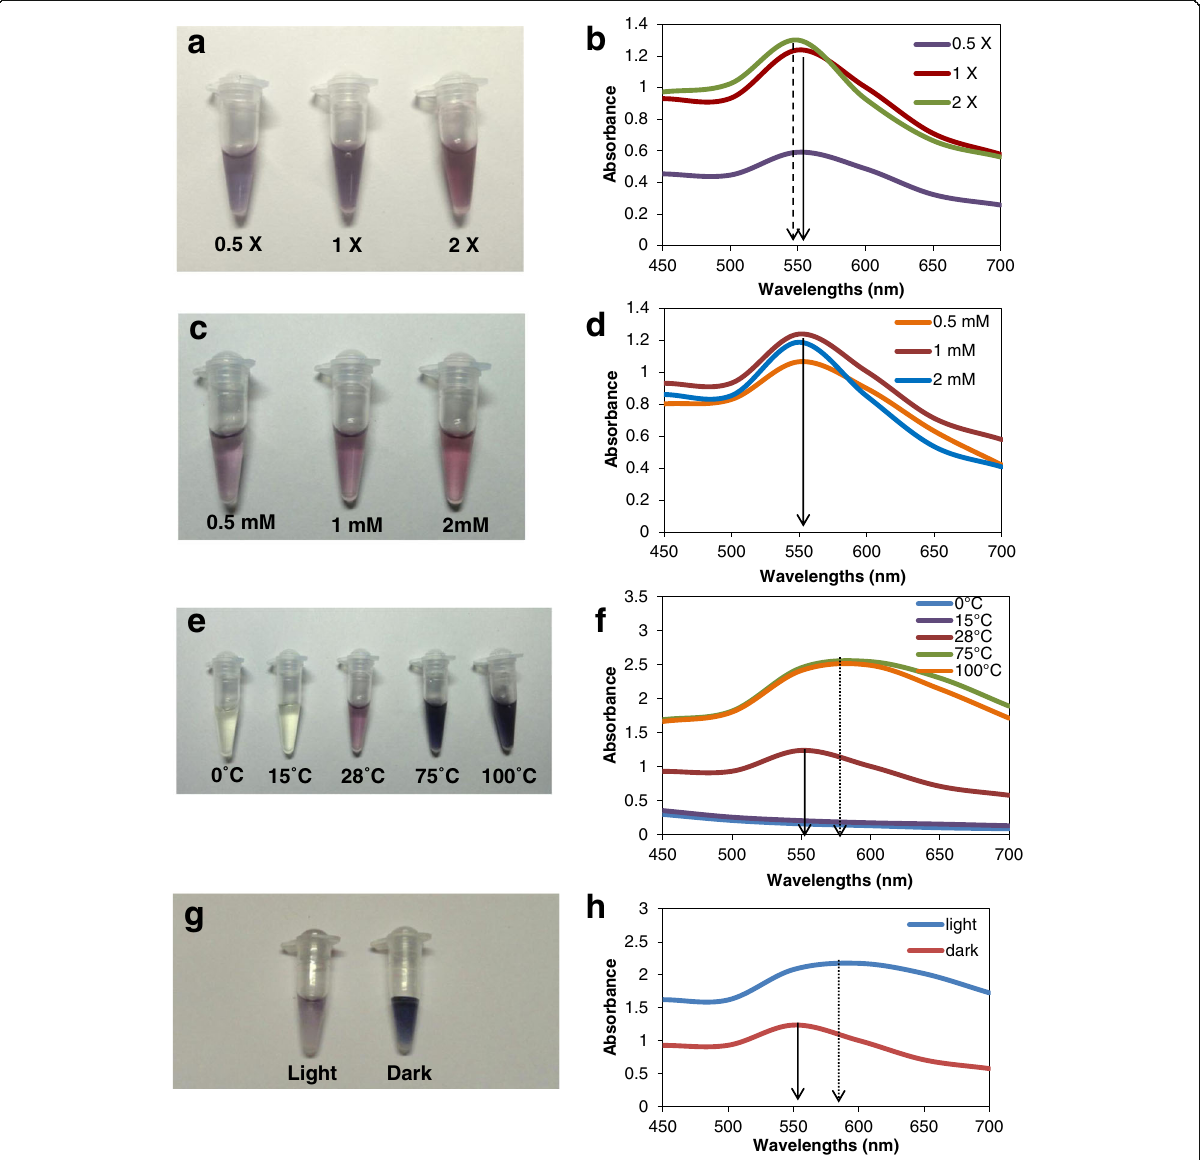
Fig. 2 Biosynthesis and UV-vis spectroscopy of AuNPs from Tricholoma crassum using different synthesis parameters. a , b Different concentrations of cell-filtrate. c , d Different concentrations of HAuCl 4 . e , f Different reaction temperatures. g , h In dark and under light. Solid arrow shows the typical absorption peak at 552 nm for × 1 cell filtrate and 1 mM HAuCl 4 at 28 °C pH 5.5 and dashed arrow indicates blue shift of absorption maxima, dotted arrow shows red shift in SPR